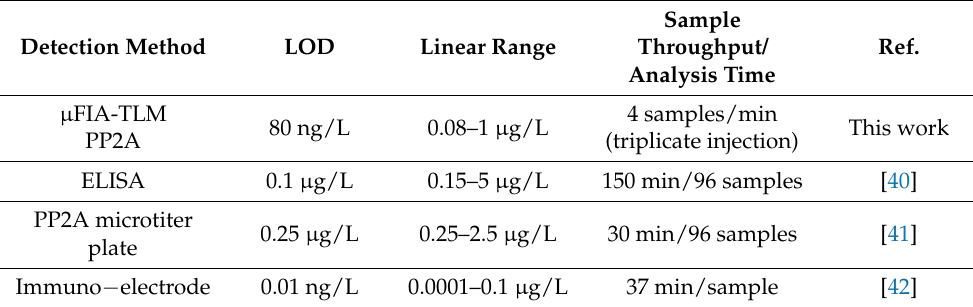
Table 1. Comparison of figures of merit for the µ FIA-TLM PP2A method and existing methods for detection of